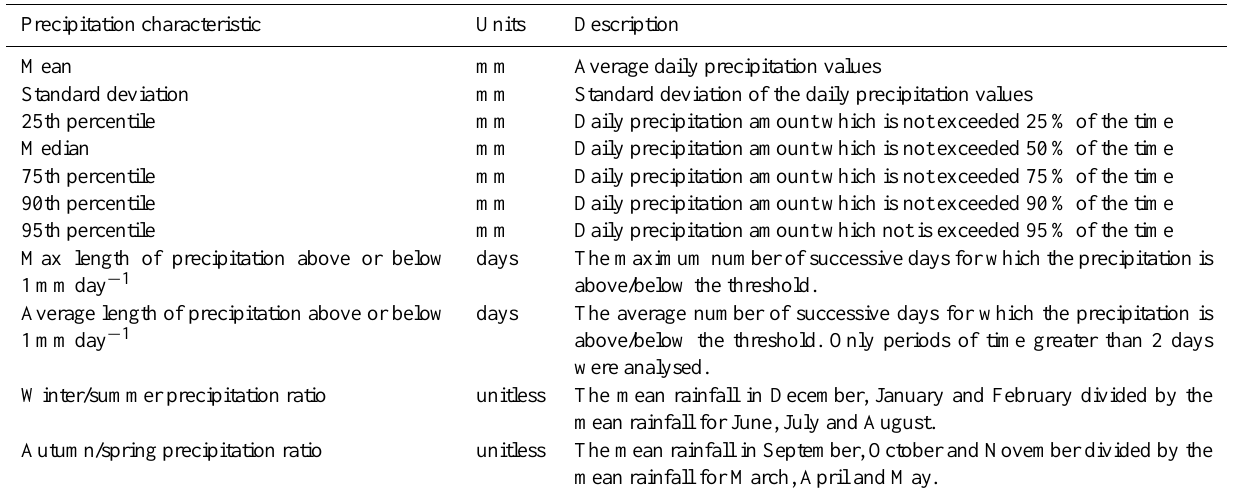
Table 1. Daily precipitation characteristics.